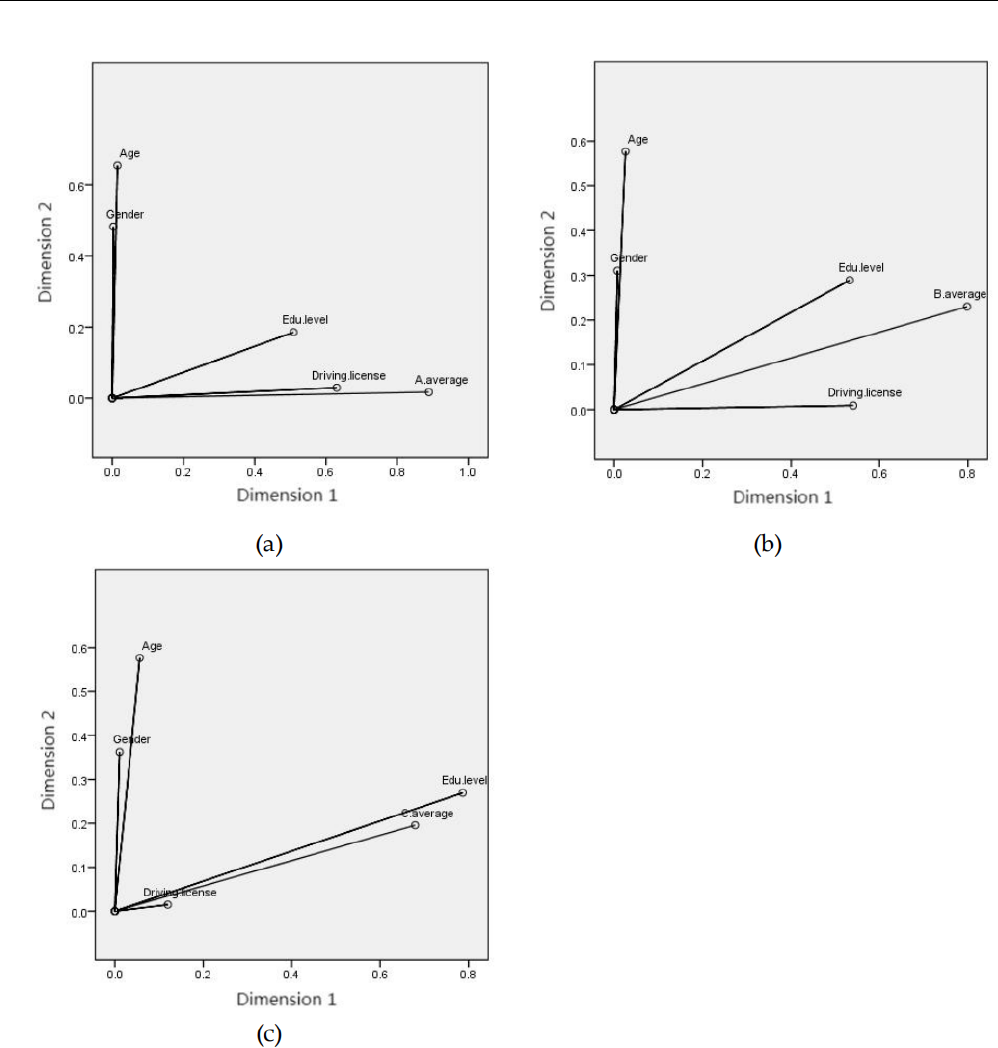
Figure 5. Discrimination measures of the variables: ( a ) Correspondence between the public’s char- acteristics and variable A. ( b ) Correspondence between the public’s characteristics and variable B. ( c ) Correspondence between the public’s characteristics and variable C. Table 6. Discrimination measures of the variables.